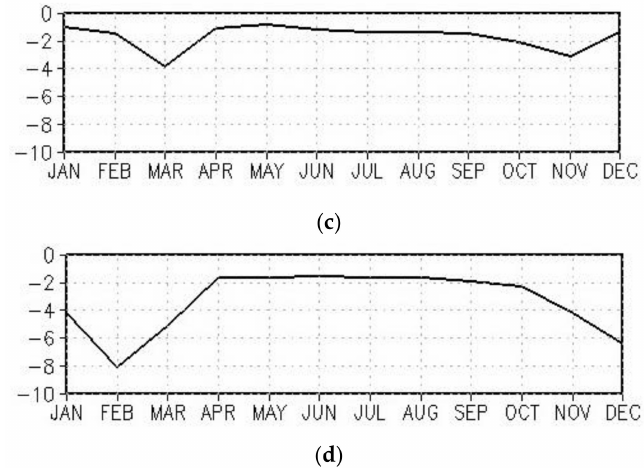
Figure 1. Difference of the zonal mean temperature (K) in the range of pressure levels from 1000 hPa to 1 hPa averaged over December–February ( a , b ), and difference of a seasonal cycle of the zonal mean temperature averaged over 70 ◦ N–90 ◦ N at pressure level 30 hPa ( c , d ) between two periods,